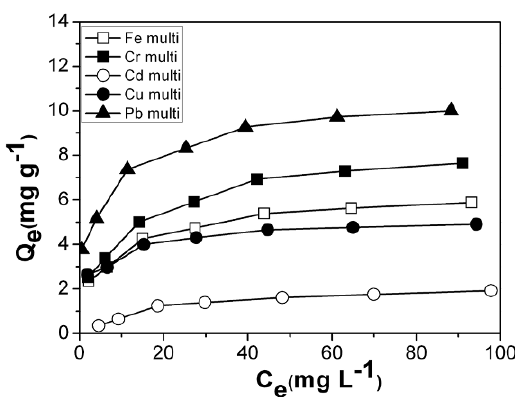
Figure 8. Adsorption isotherms for multi-component solutions containing Cu(II) - ● , Fe(III) - □ , Cr(III) - ■ , Cd(II) - ○ and Pb(II) - ▲ onto Si-10Al